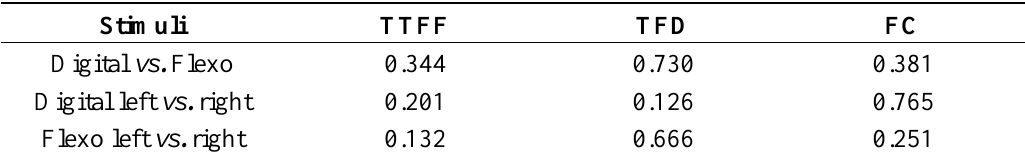
Table 1. Overview of p -values.